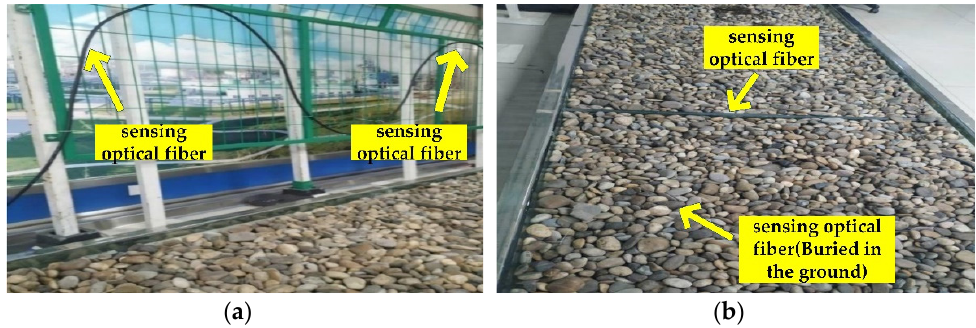
Figure 3. The actual measurement environment: ( a ) hung nets; ( b ) buried.